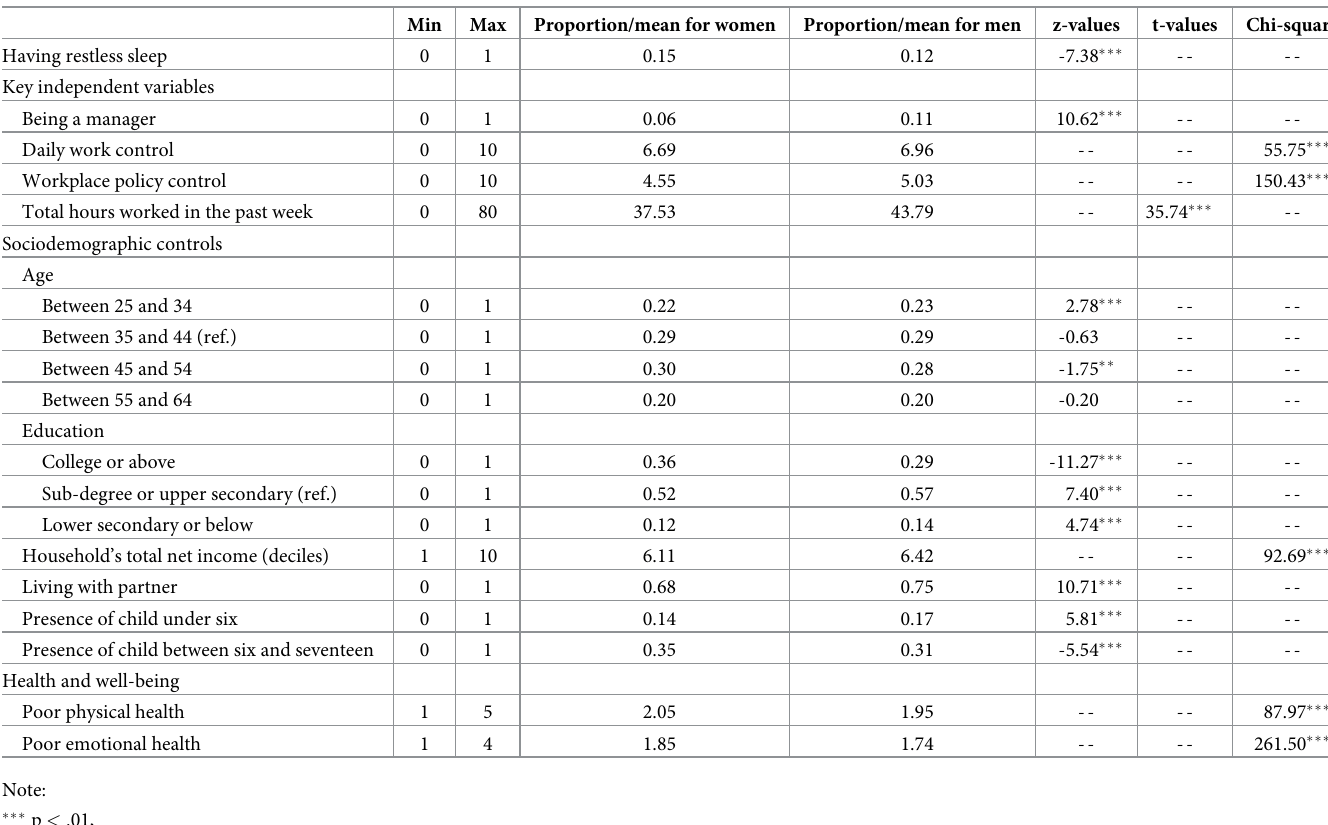
Table 2. Descriptive data of individual-level